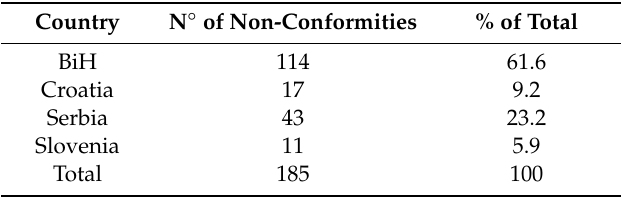
Table 5. The number and distribution of non-conformities by